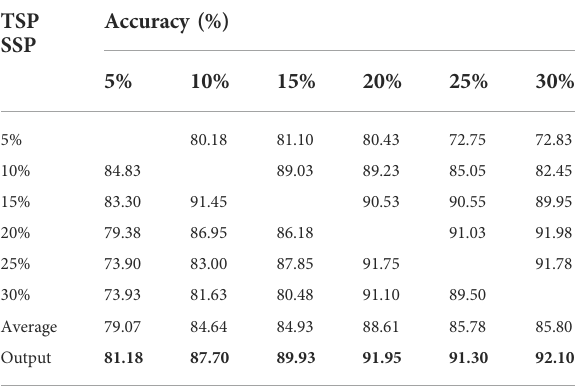
TABLE 2 Benchmark results of the method on simulated